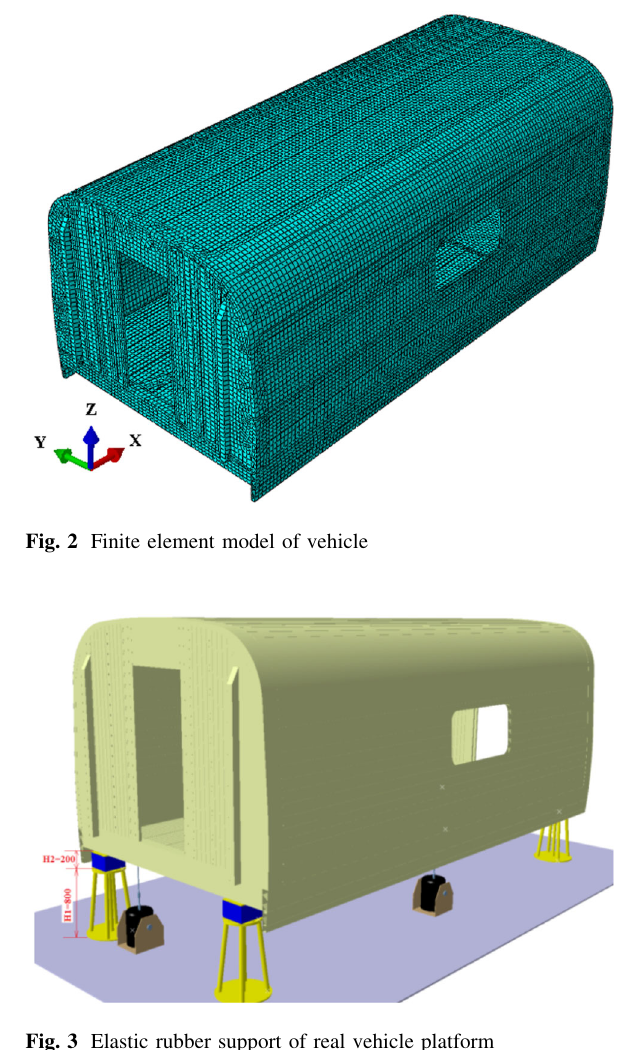
Fig. 3 Elastic rubber support of real vehicle platform